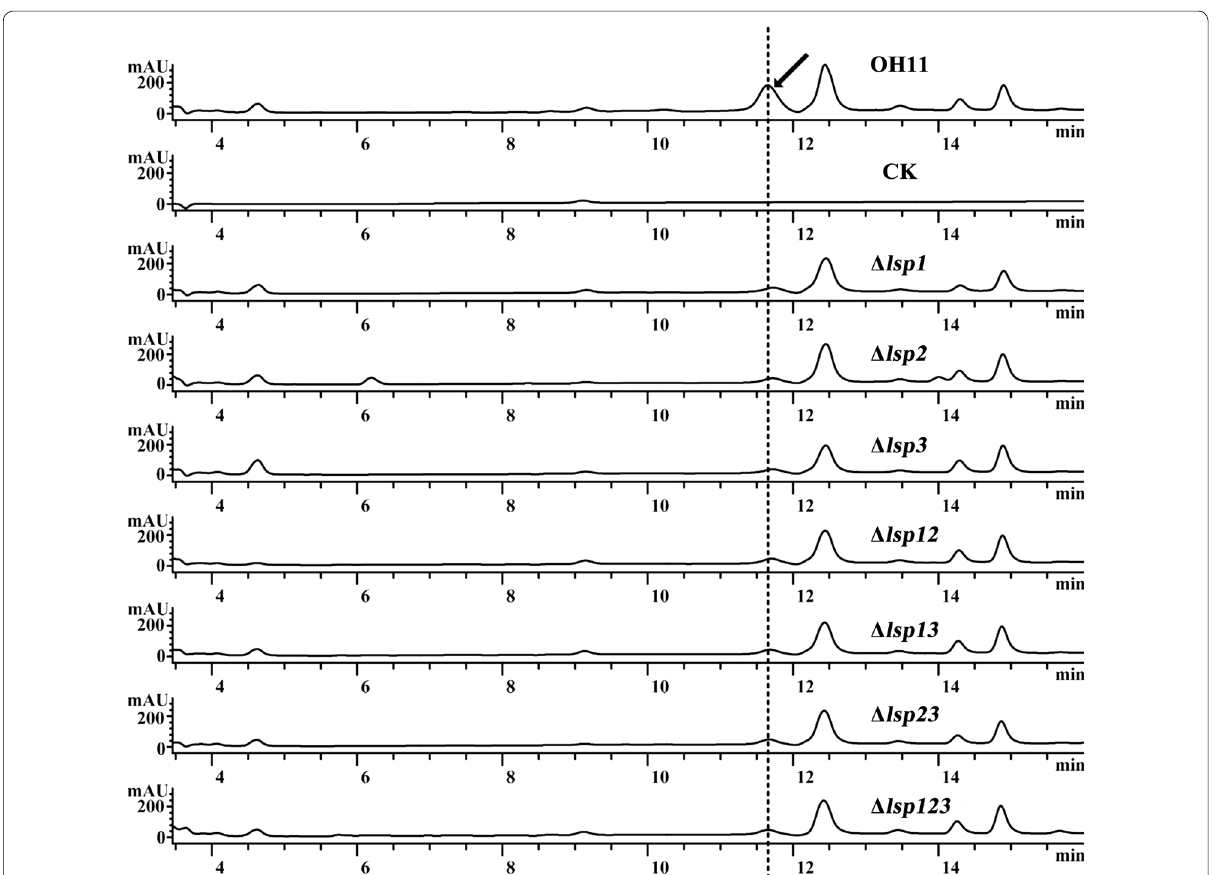
Fig. 4 Inactivation of lsp genes individually or in various combinations caused a decrease in the WAP-8294A2 production. The identity of each strain in this figure is provided in the captions for Figs. 2 and 3. ‘CK’ is the solvent (methanol)-only control. The arrow indicates the peak